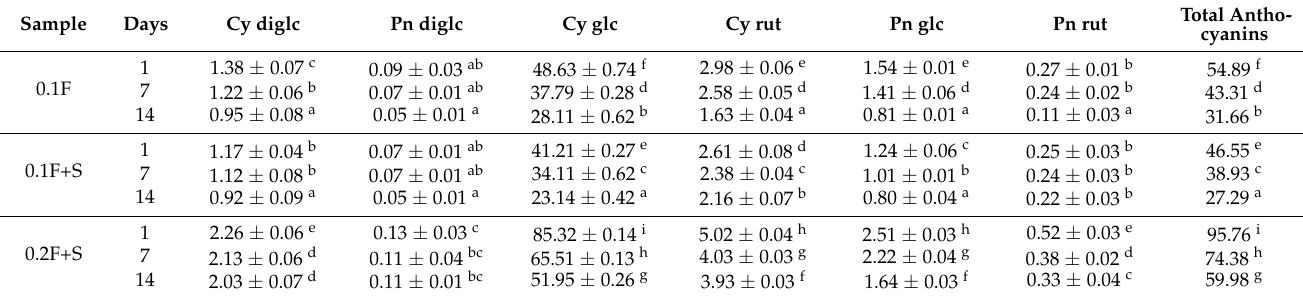
Table 8. Changes of anthocyanins contents (mg/L) in yoghurt samples during storage.